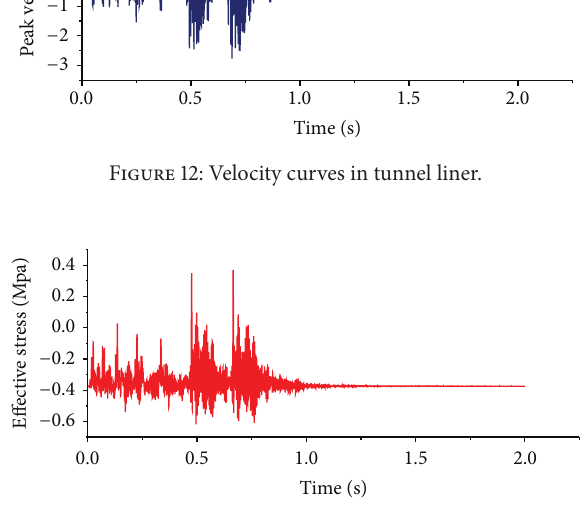
Figure 13: Tensile stress curves in tunnel liner.